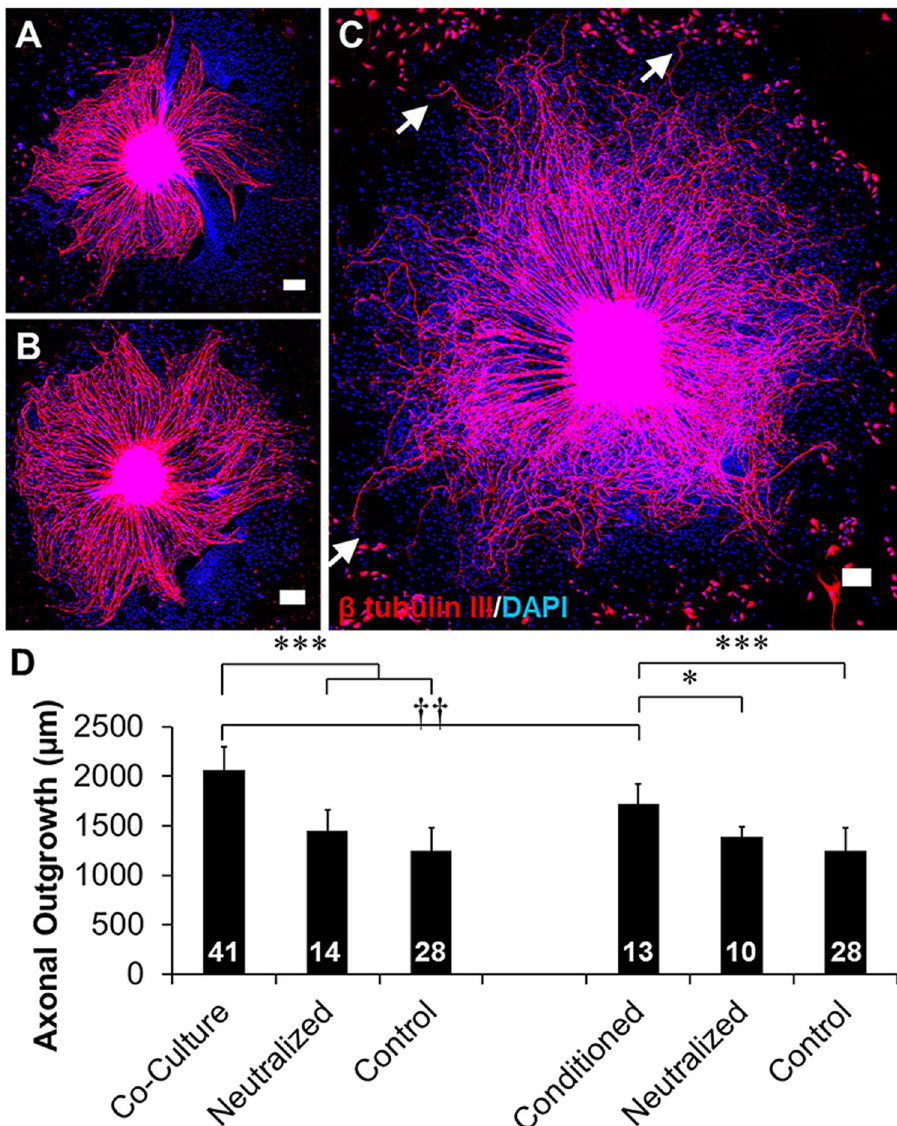
Figure 8. HUVEC co-culture and HUVEC-conditioned medium significantly enhanced rat DRG (rDRG) axonal growth. To confirm that HUVEC mediated axonal growth was applicable to mammalian systems, rDRG explants were cultured ( A ) on PDL wells (control), ( B ) in HUVEC-conditioned medium (conditioned), and ( C ) in direct co-culture with HUVECs (co-culture). Axons grew towards clusters of HUVECs when cultured in direct contact with HUVECs (arrows), and axons from DRGs grown on PDL well or with HUVEC-conditioned medium displayed radially symmetrical growth. Scale = 200 µ m. Axonal outgrowth from ( D ) direct co-culture between low densities of HUVECs and rDRGs and from HUVEC-conditioned medium is significantly higher than control axons cultured on PDL wells (controls) and cultures supplemented with neutralizing antibody. Additionally, direct co-culture of HUVECs and rDRGs supported significantly longer axonal outgrowth than outgrowth from rDRGs cultured in HUVEC-conditioned medium. Data are presented as mean ± standard error. * (p < 0.05), *** (p < 0.001) and brackets indicate significance from indicated treatments by one- way ANOVA with Holm-Sidak post hoc analysis and †† (p < 0.01) indicates significance between indicated treatments as determined two-tailed Student’s t-test (DRG sample size for each group shown in bars from 2–3 independent